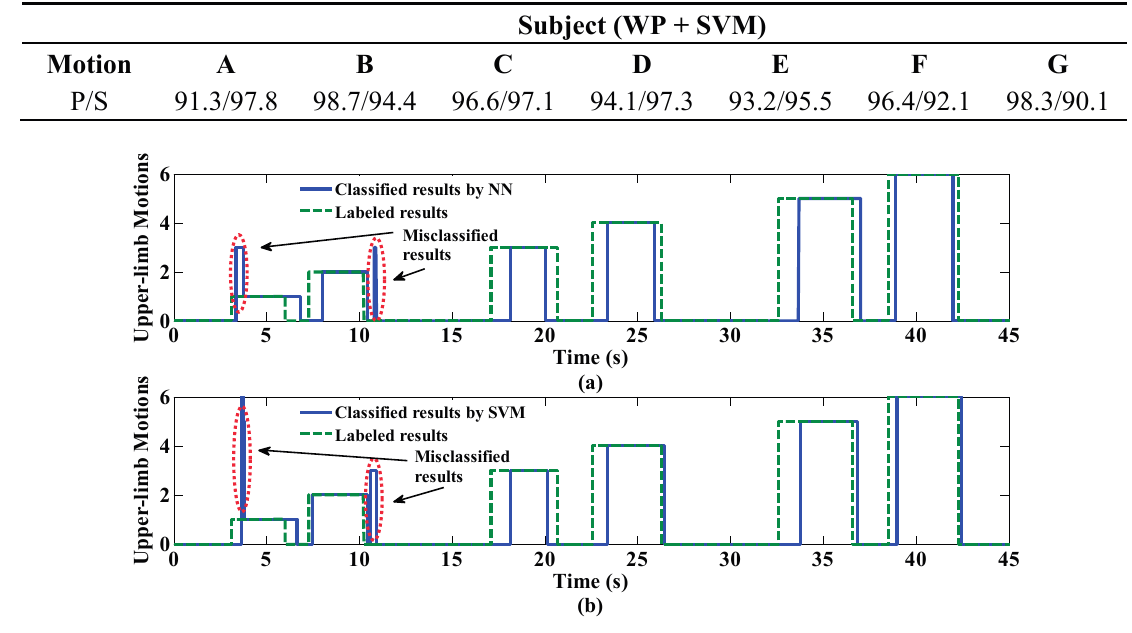
Table 4. Recognition accuracy rate for forearm pronation and supination.